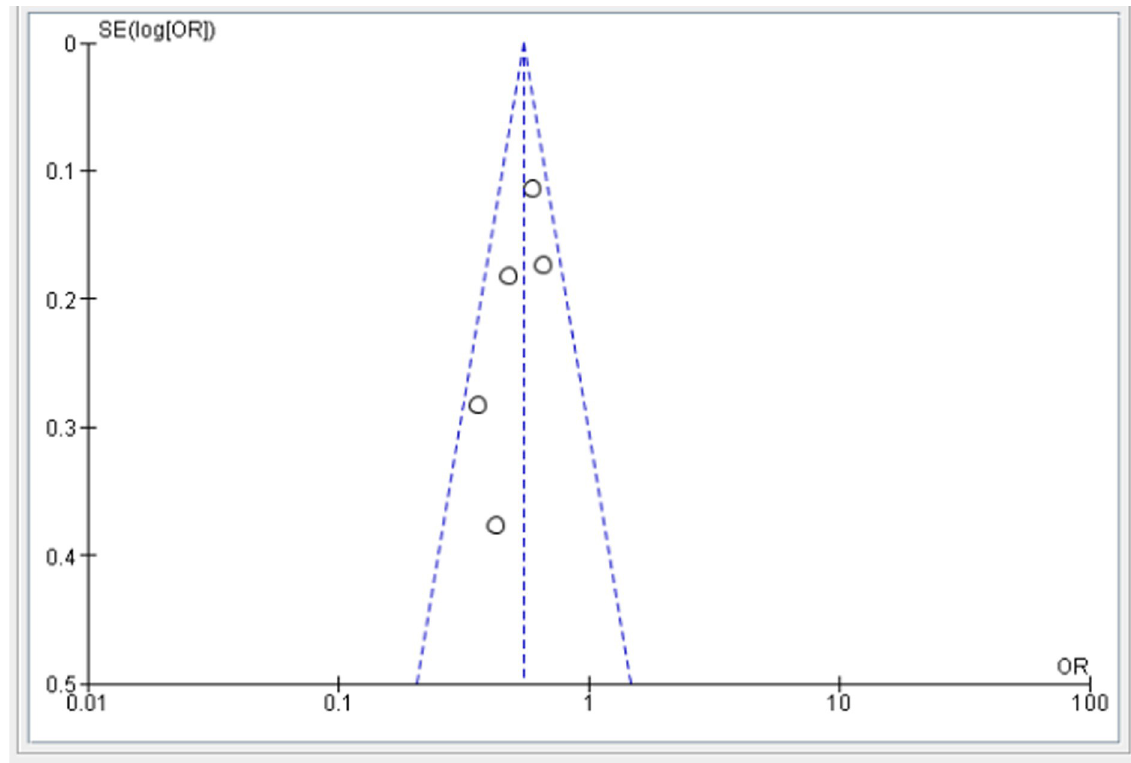
Fig 5. Funnel plot of five studies to show the effect of secondary and above maternal education on infant mortality in Ethiopia.